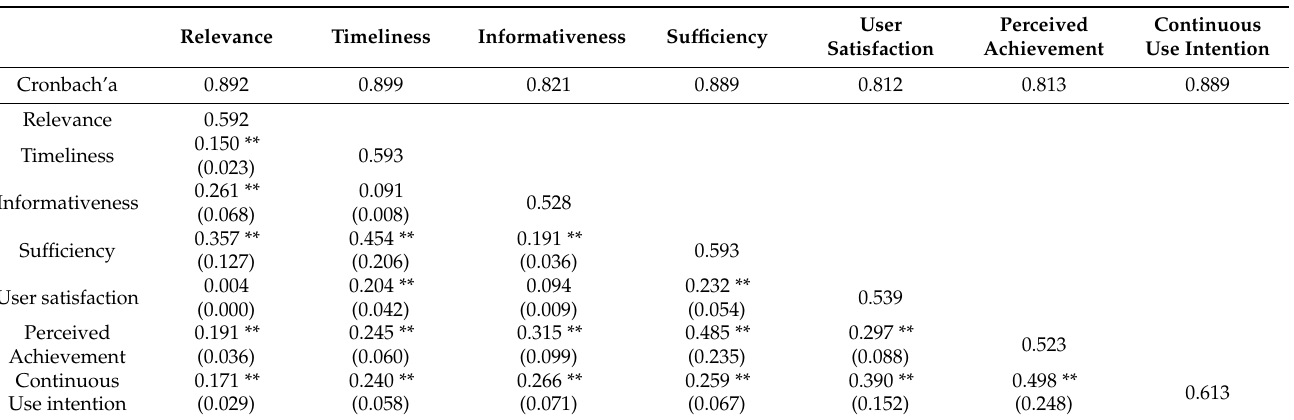
Table 3. Correlation matrix for the overall measurement model and